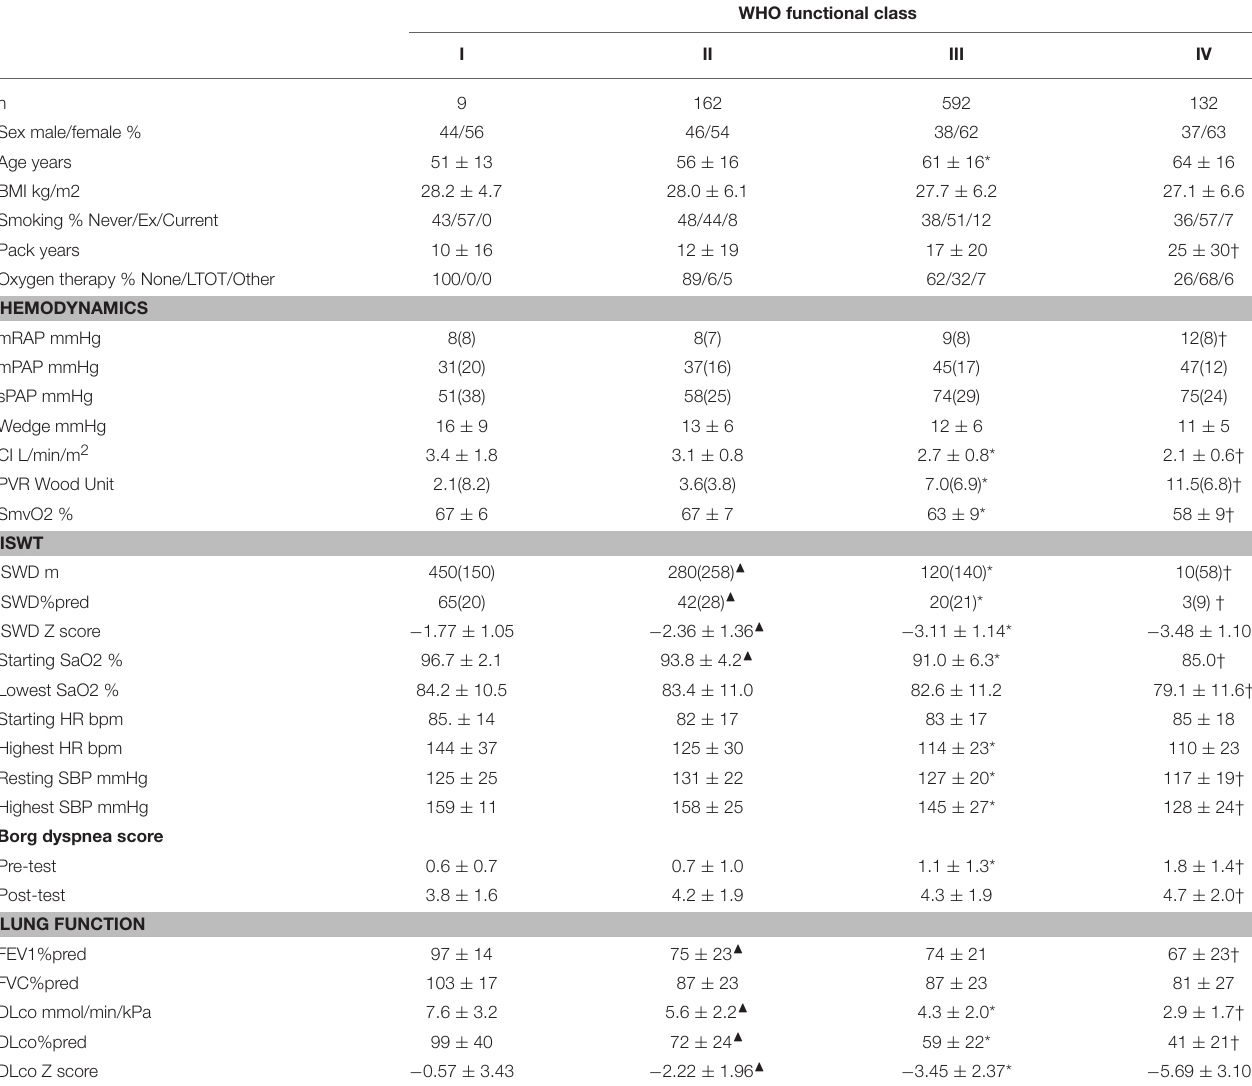
TABLE 1 | Patient characteristics and hemodynamic